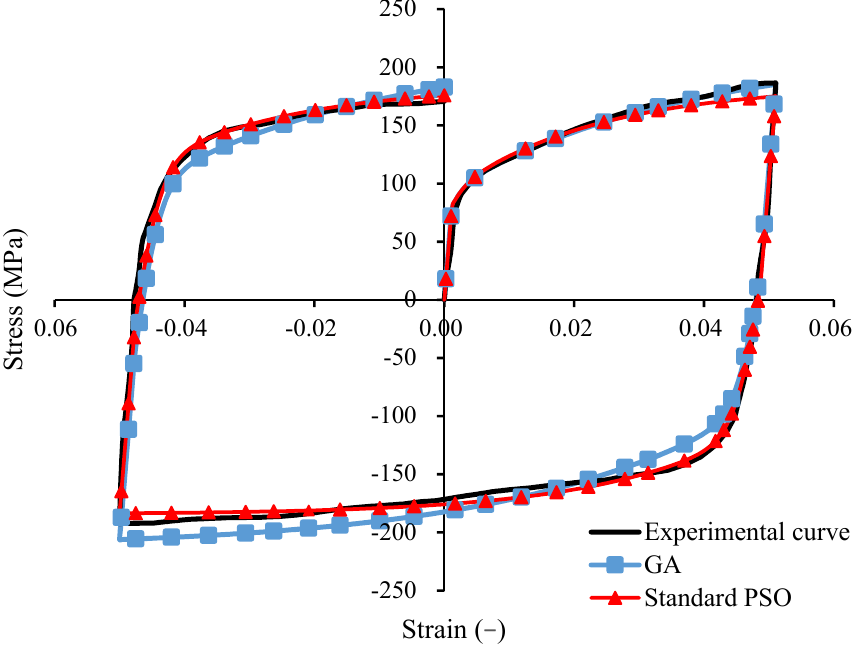
Figure 7. Simulated stress-strain response curve: GA and standard PSO.